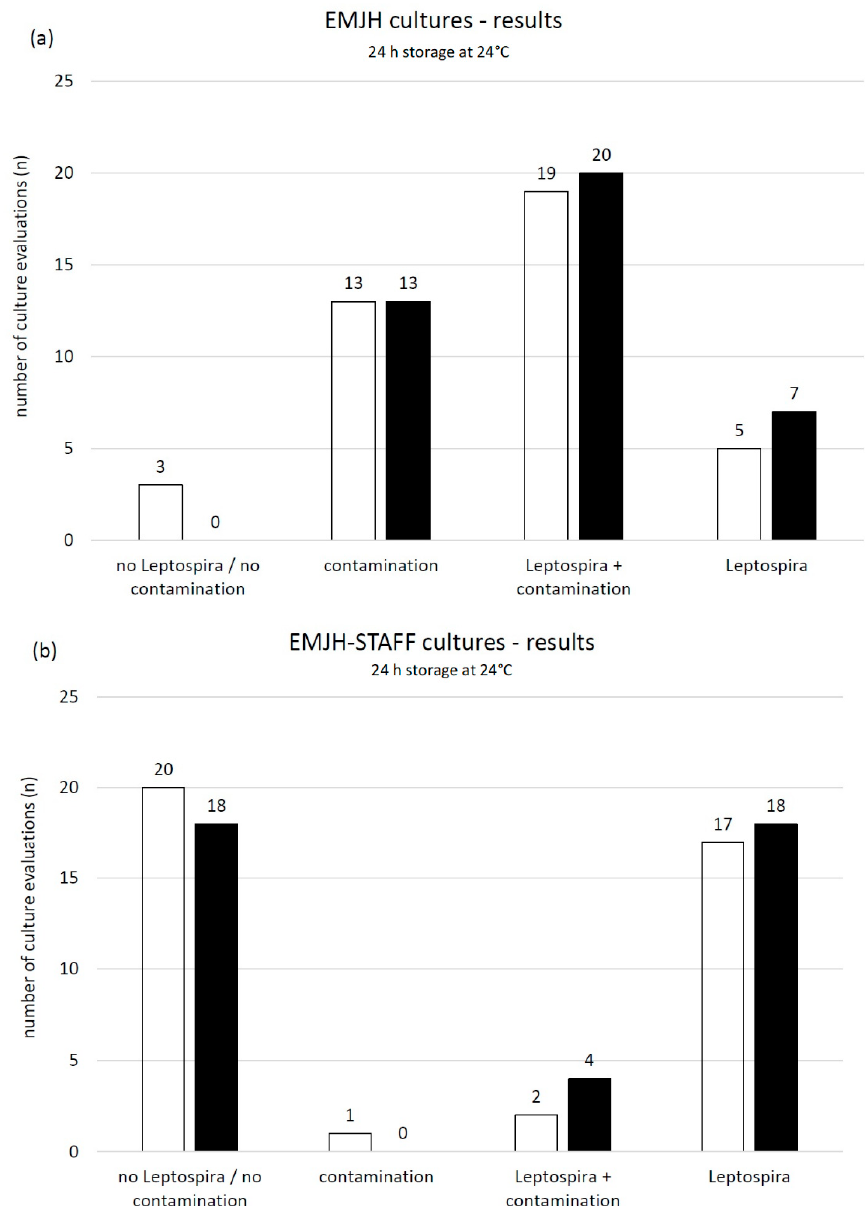
Figure 6. Number of microscopic (dark field, 200 × ) evaluations including week one, two, three and four post inoculation of ( a ) ten EMJH and ( b ) ten EMJH-STAFF cultures from spiked swine urine samples stored for 24 h at 4 ◦ C (cid:3) without and (cid:4) with added buffer (PBS) and differentiated into the following categories: no Leptospira/no contamination, contamination, Leptospira plus contamination and pure